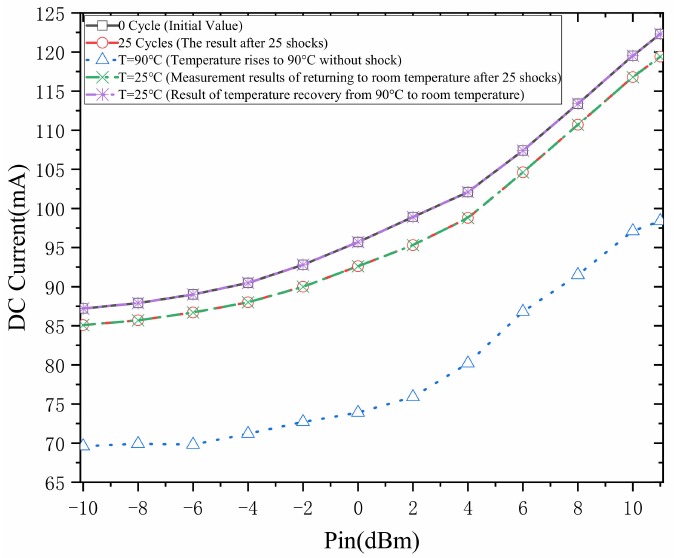
Figure 4. DC current of PA under thermal shock test and temperature